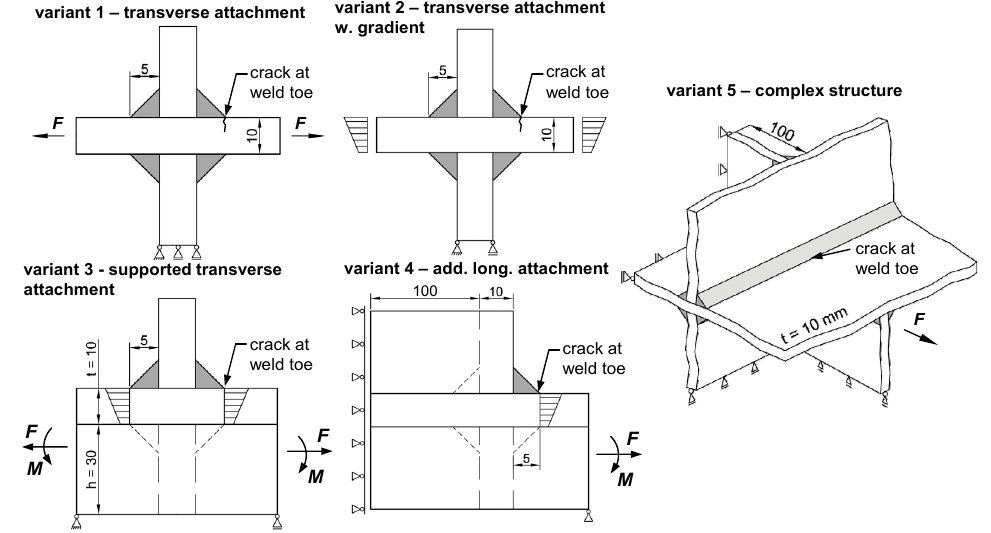
Figure 1: Selected geometrical variants (variants 1 to 4 are cut in the symmetry